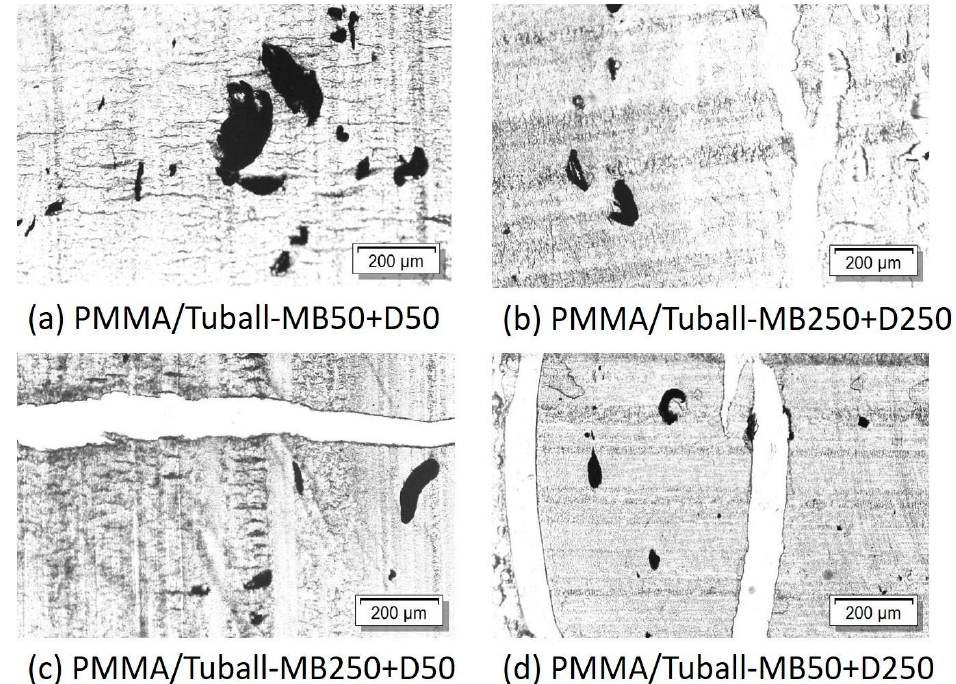
Figure 2. LM images of samples containing 1 wt% SWCNT prepared by masterbatch approach at different rotation speeds. 50 rpm/50 rpm ( a ), at 250 rpm/250 rpm ( b ), at 250 rpm/50 rpm ( c ), at 50 rpm/250 rpm ( d ) (rotation speed at masterbatch preparation/rotation speed at masterbatch dilution) (lines in the images are related to the brittleness of the samples and represents folds from the cutting process).